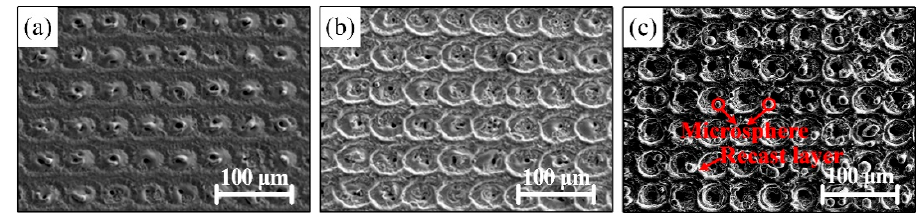
Figure 8. Morphology of microdimples created using laser processing with different numbers of passes: ( a ) 100, ( b ) 300, ( c ) 500.